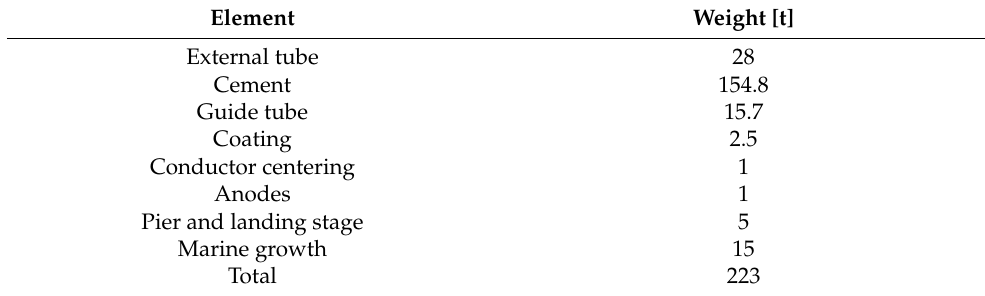
Table 1. Platform material inventory according to ENI S.p.A. estimates.